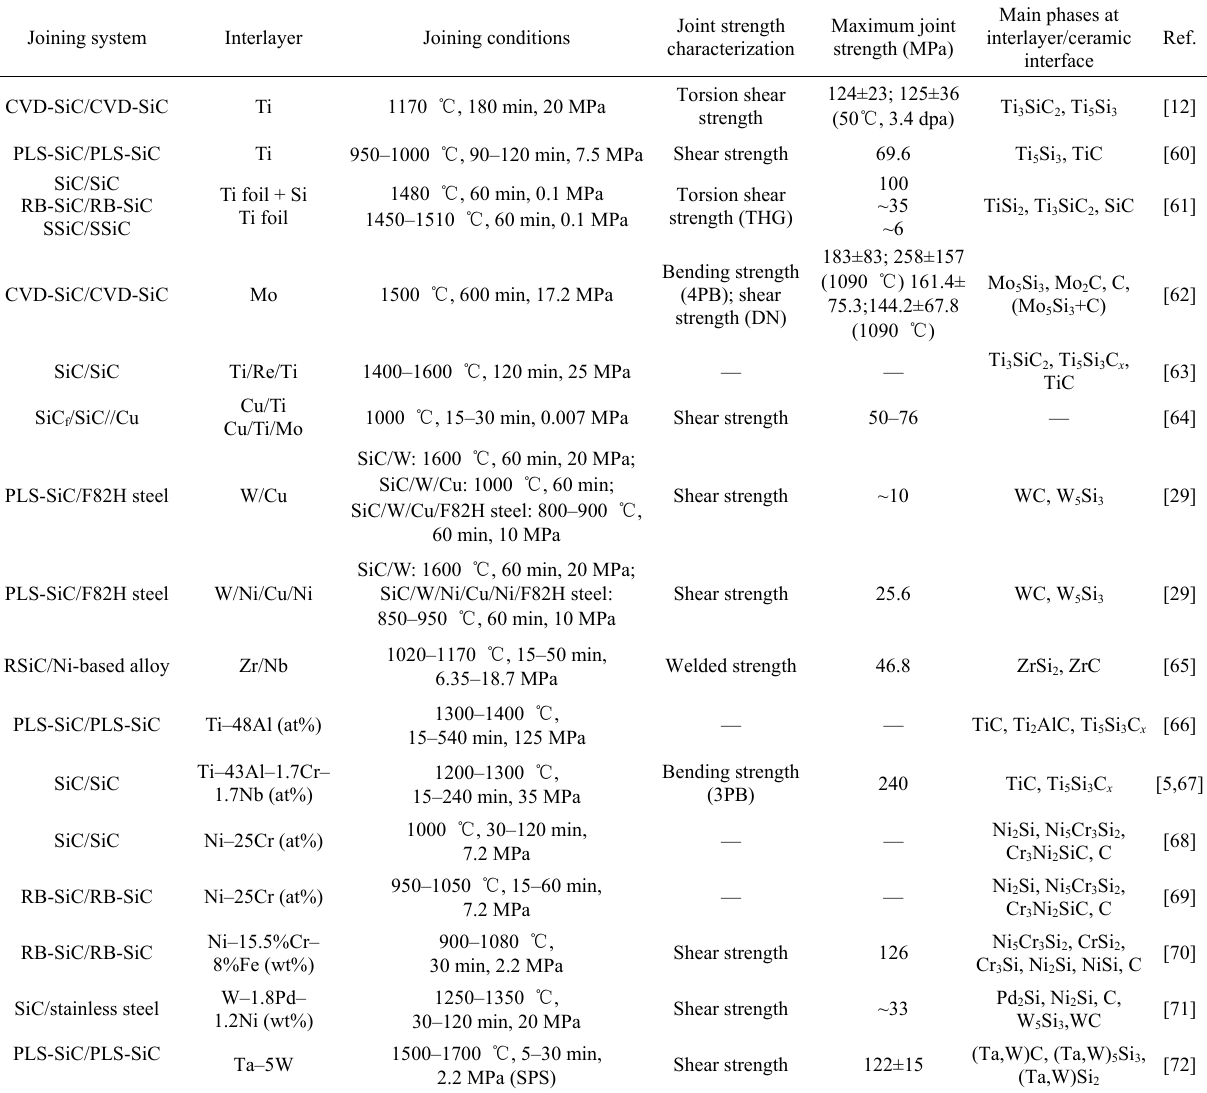
Table 4 Diffusion bonding of SiC-based materials using metallic materials as interlayer: interlayer, joining conditions, joint strength, and main phases at interlayer/ceramic interface Joining